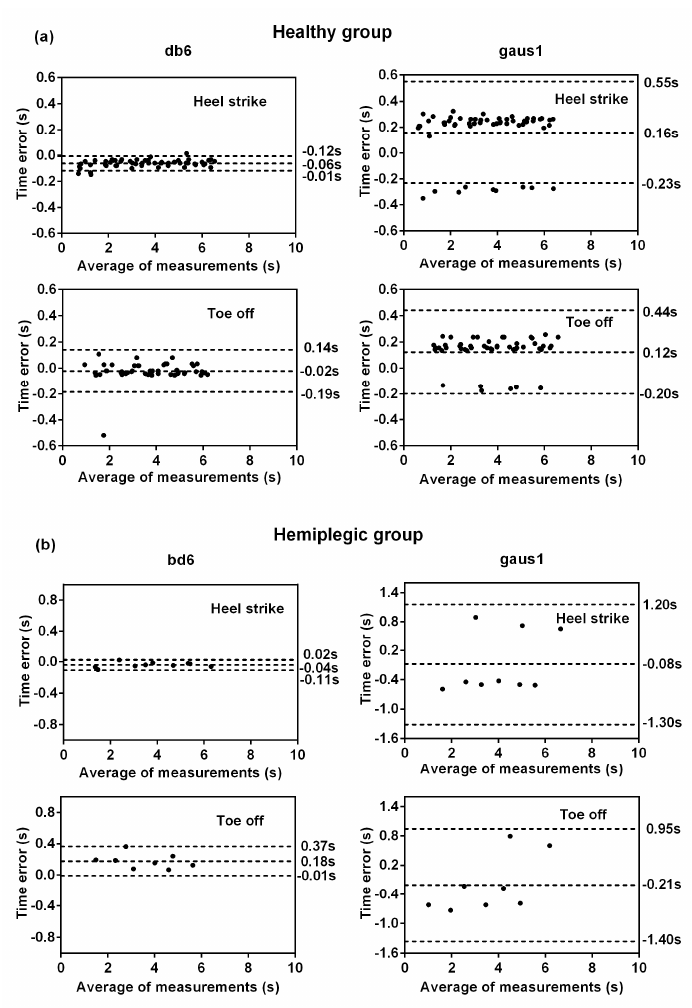
Figure 6. Bland–Altman plots of time agreement between the proposed modified CWT algorithm and the FSR method for HS and TO gait event detection in the healthy group ( a ) and the hemiplegic group ( b ). The time agreement results of selecting the optimal wavelet “db6” are shown on the left side whereas results of the commonly used wavelet “gaus1” with rather poor performance are shown on the right side. Positive times correspond to delays in the gait event detection of the proposed modified CWT algorithm with respect to the reference FSR method. The horizontal axis represents the average time measures for detecting gait events by both methods, and the vertical axis is the time error between the two methods. The dashed line from top to down respectively represent the 95% CI upper limit, the mean, 95% CI lower limit of the time difference (in seconds).